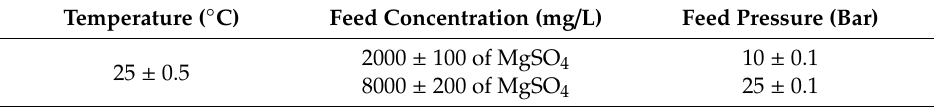
Table A1. Concentration polarization experiments operating conditions.